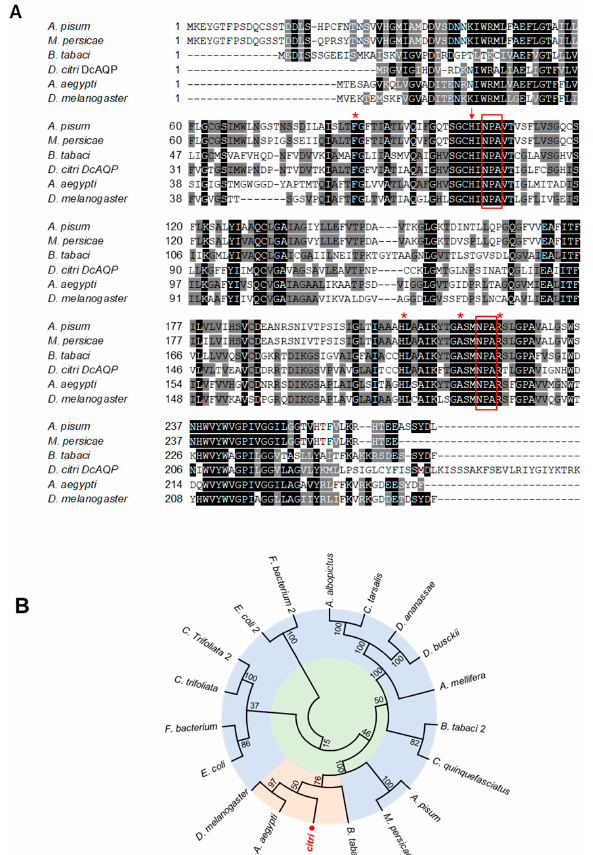
Figure 1. In silico analysis of aquaporin homologue ( DcAQP ) of Diaphorina citri . ( A ) Multiple sequence alignment of amino acid sequence of AQPAe.a from D. citri ( DcAQP ; accession no. XP_008484232.1) and AQPs from other insects, including A. pisum (accession no. NP_001139376.1), B. tabaci (accession no. XP_018906592.1; ABW96354.1) and M. persicae (accession no. A0A0H3XRM3) from Hemiptera and A. aegypti (accession no. Q9NHW7.2) and D. melanogaster (accession no. NP_001286316.1) from Diptera. Conserved amino acids are indicated with black shading, and those with high similarity score are in gray. The conserved NPA domains are surrounded by red boxes. The AA contributing to the aromatic–arginine (ar/R) region located on the extracellular side of the cell membrane are indicated with red asterisks. ( B ) Evolutionary relationships using an unrooted tree of protein sequences of DcAQP from D. citri and AQPs from other organisms. The analysis involved 19 amino acid sequences. The DcAQP (XP_008484232.1) is colored in red and is marked with a red dot. The full list of genes, names, and accession numbers is available in supplementary Table S2.